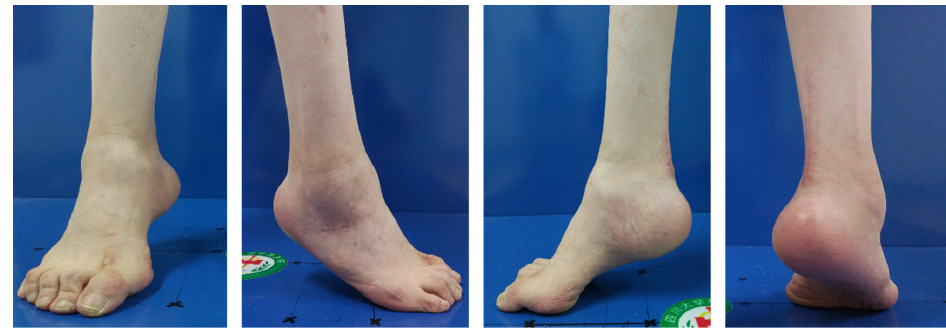
Figure 4. The outlook of unilateral pes calcaneocavus deformity.